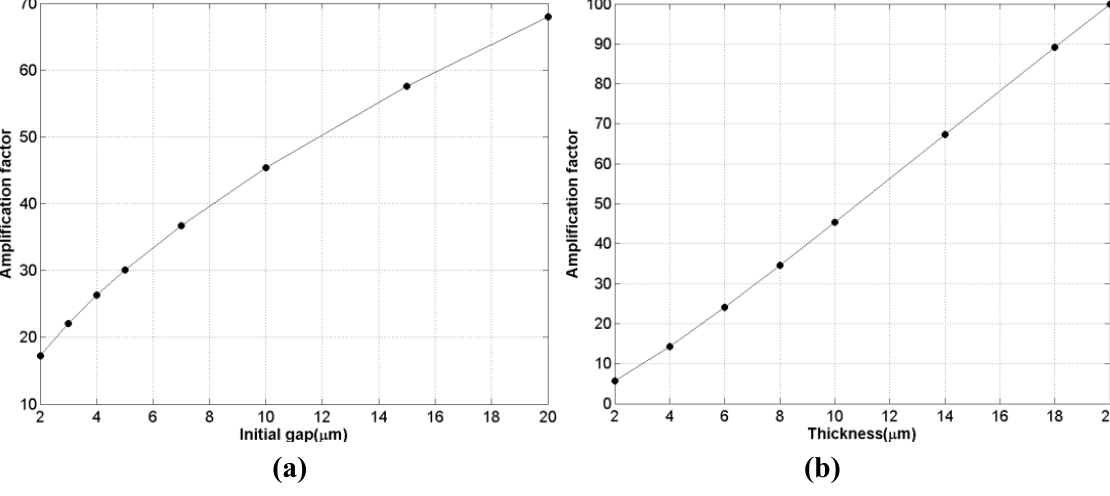
× g ) and without electrostatic 0